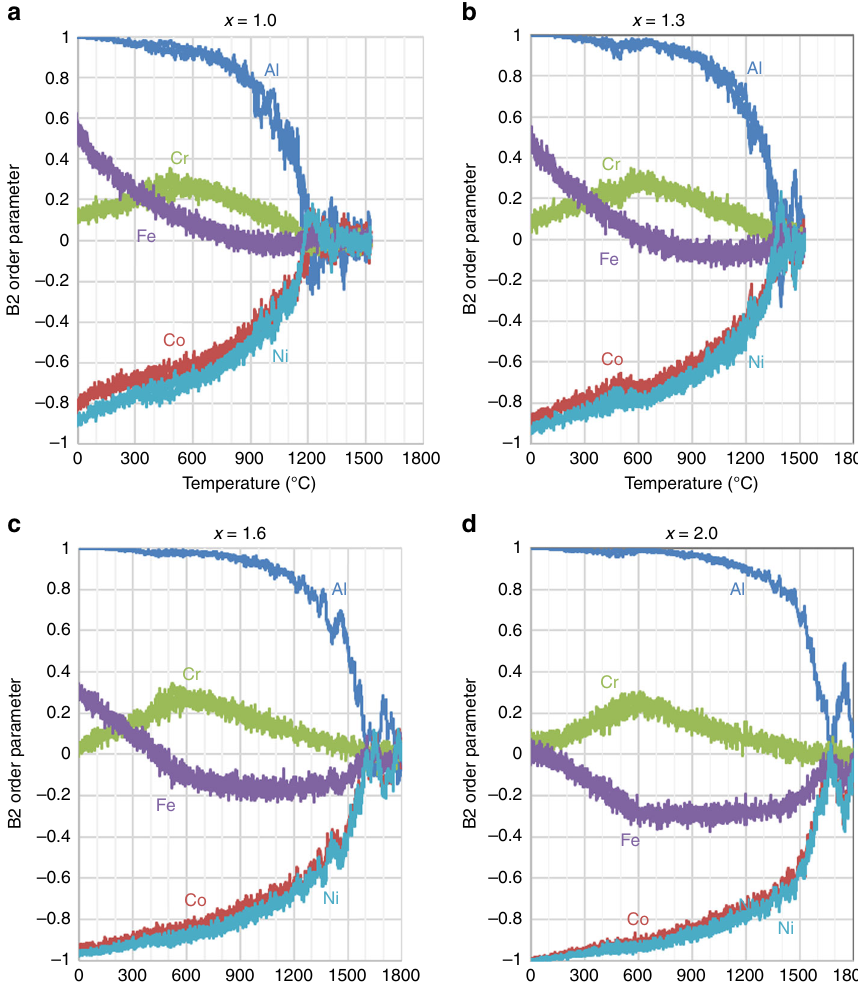
Fig. 3 Simulated con fi gurational order. The element-speci fi c B2-order parameters obtained from Monte Carlo simulations are plotted for the Al x CoCrFeNi family of alloys. A comparison of four different aluminium contents, a x = 1.0, b x = 1.3, c x = 1.6, and d x = 2.0, shows that the order parameters all tend toward zero above a suf fi ciently high temperature (i.e., the ordering-onset temperature), which increases with increasing Al content. More importantly, the two distinct behaviors of the strongly ordering (Al, Co, and Ni) and disordered (Cr and Fe) groups of elements, which are seen in all the plots, are crucial